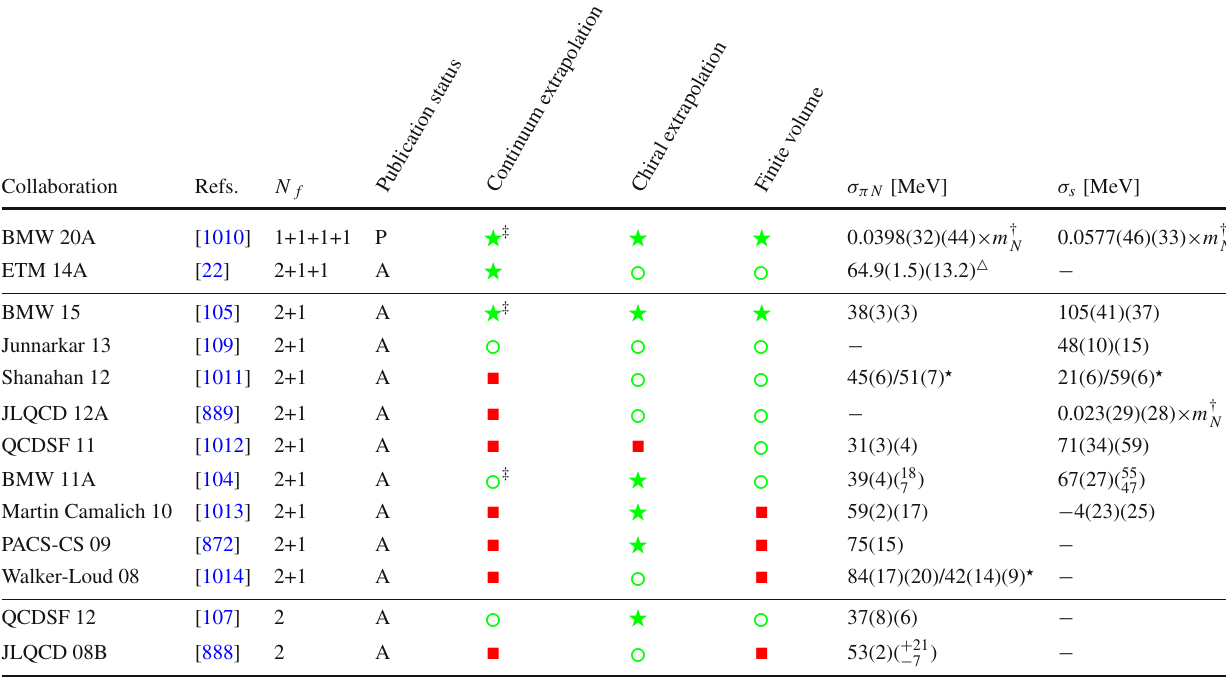
(cid:27) Two results for σ π N are quoted arising from different fit ansätze to the nucleon mass. The systematic error is the same as in Ref. [1015] for a combined N f = 2 and N f = 2 + 1 + 1 analysis [1016] ‡ The rating takes into account that the action is not fully O(a) improved by requiring an additional lattice spacing (cid:24) Two results are quoted = f + f = σ π / m = σ / m † The quark fractions f T ud T u T d N N and/or f T s s N are